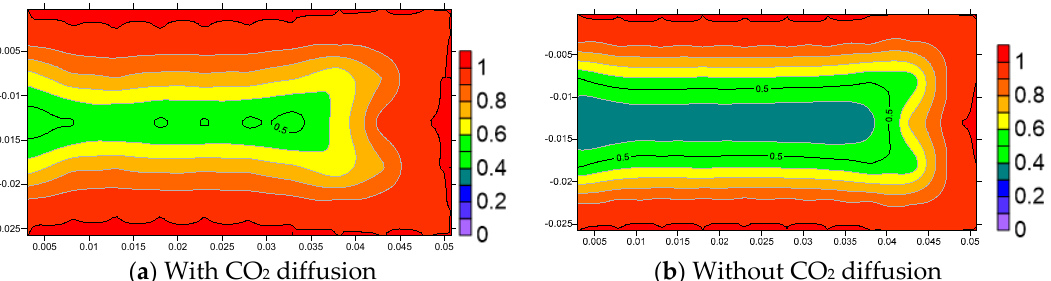
Figure 20. Oil recovery comparison of CO 2 huff-‘n-puff with and without diffusion (Case-4).